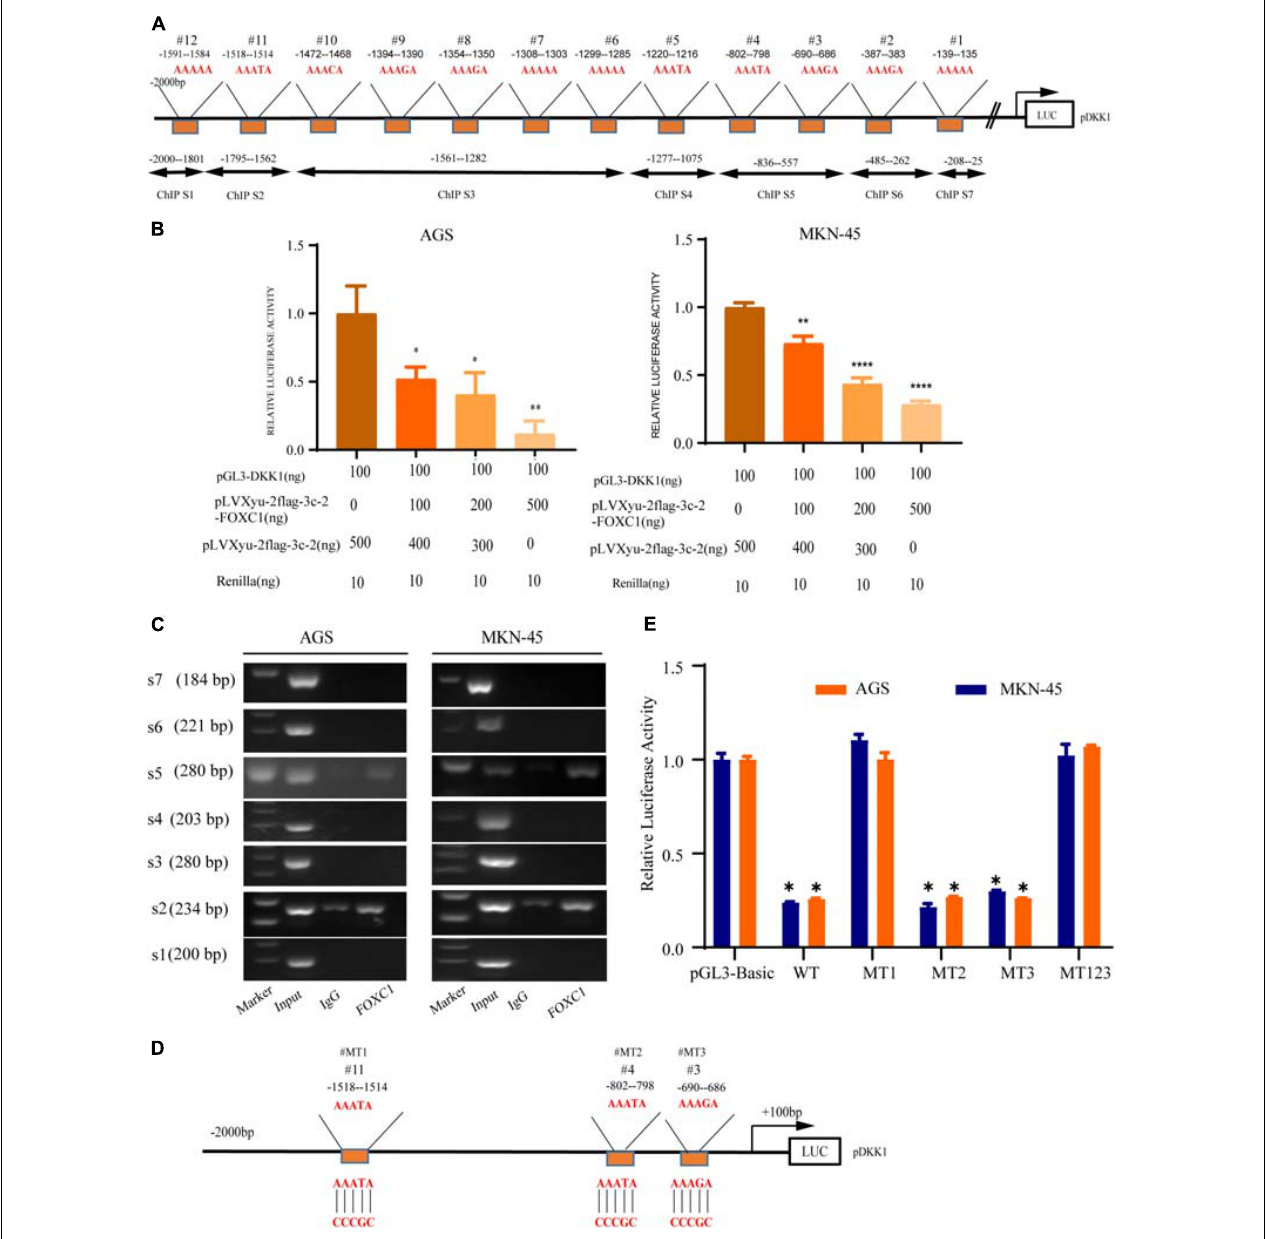
FIGURE 7 | DKK1 is downstream of FOXC1 in GC. (A) Considering the specific DNA sequence for FOX transcription factor (AAAYA), A total of 12 putative FOXC1 binding sites in the 5’ untranslated region of DKK1promoter. (B) Double luciferase activity assay in AGS and MKN-45 cells to confirm the influence of FOXC1 on the transcription of DKK1. The results of Luciferase activity were dose-dependently decreased after co-transfection with FOXC1 (* P < 0.05), which is also indicated that FOXC1 negatively regulated DKK1 expression at transcriptional level. (C) Chromatin immunoprecipitation assay (ChIP) results demonstrated that FOXC1 binds directly to the DKK1 promoter at ChIP S2 and ChIP S5 in the (A) , which were consisted by three putative binding sites (site3#, site4# and site 11#). (D,E) Schematic diagram of mutation strategies in the DKK1 promoter. The results indicated that FOXC1 decreased the luciferase activity of the WT DKK1 promoter to approximately 75% of the corresponding control but did not affect the activity of MT123 or MT1 (* P < 0.05, ** P > 0.05, **** P <